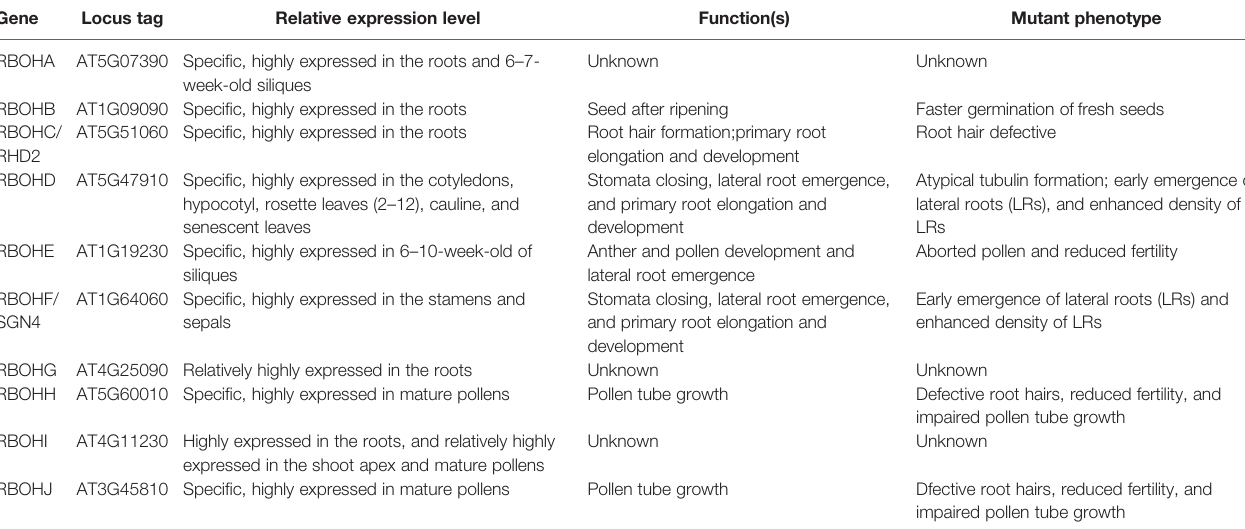
TABLE 1 | Summary of the role of the respiratory burst oxidase homolog (RBOH) isoforms in plant